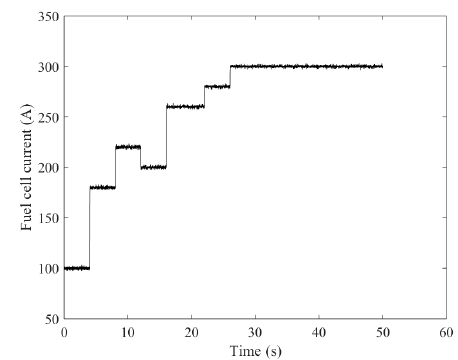
Figure 3. Fuel cell current changes with time.